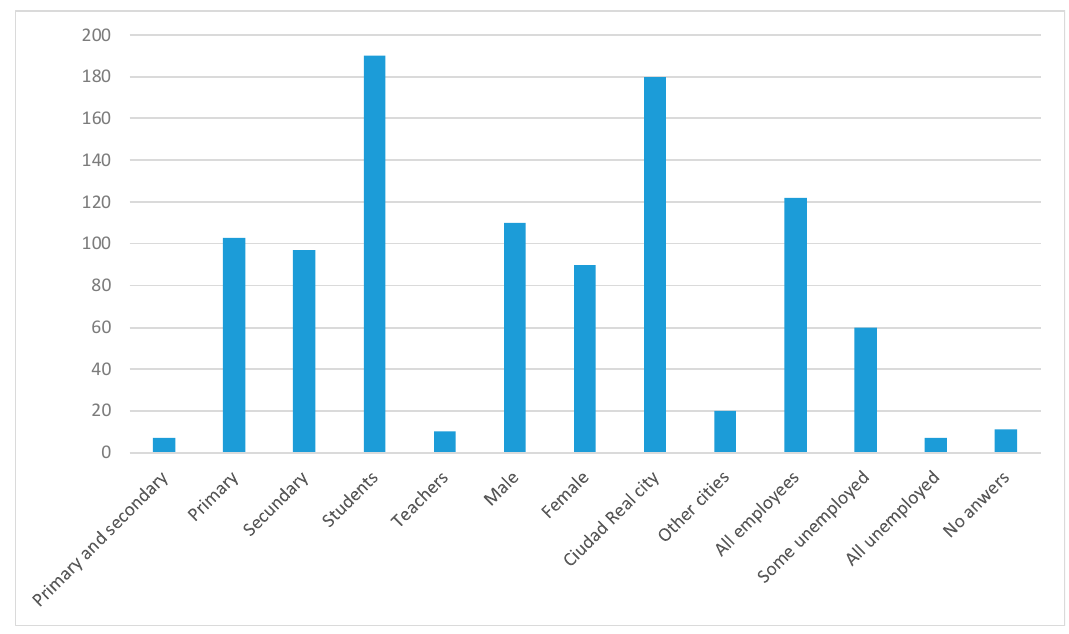
Figure 3. Descriptive results of answers. Source: Own work.